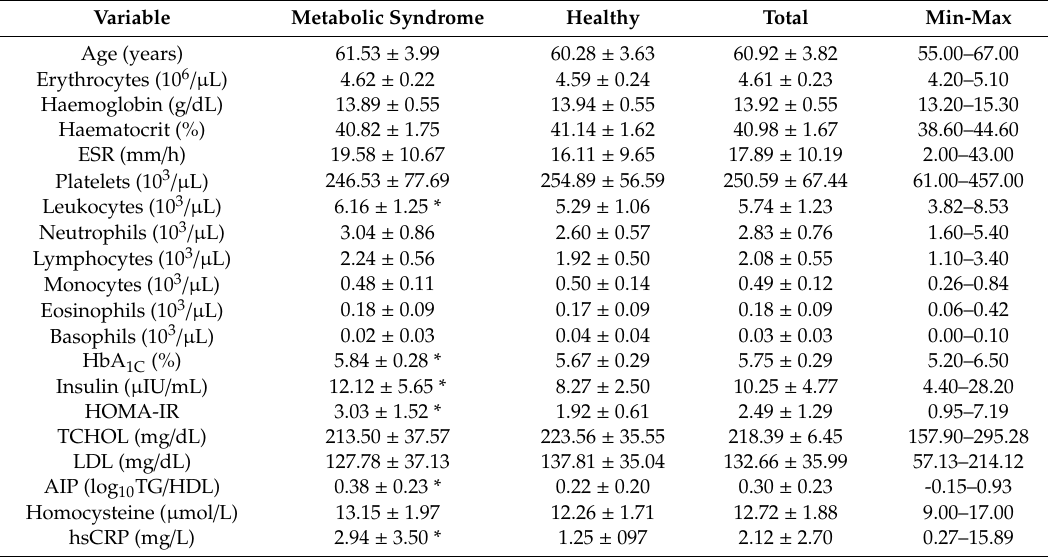
Table 1. Age and medical